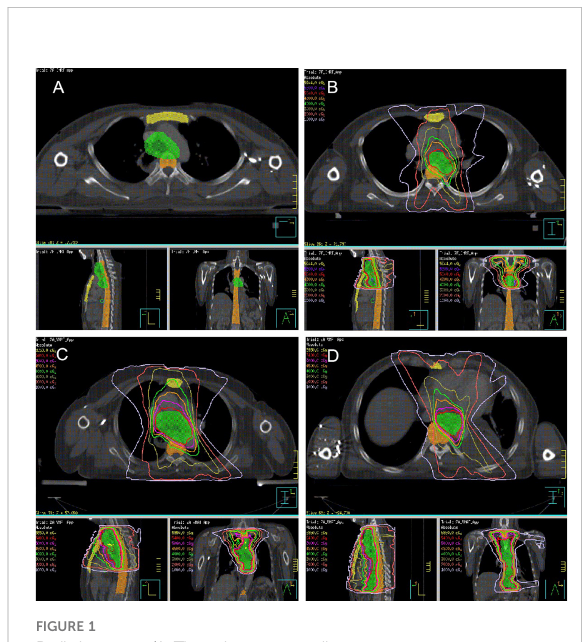
FIGURE 1 Radiation target (A. Thoracic marrow; yellow area, sternum; orange area, thoracic vertebral body; green area, PTV; (B) POCRT; (C) PORT, Upper-thoracic esophagus or Middle-thoracic esophagus with metastasis in 0 to 2 regional lymph nodes or metastasis in ≥ 3 regional lymph nodes in the mediastinum; (D) PORT, Lower-thoracic esophagus or middle-thoracic esophagus with metastasis in ≥ 3 regional lymph nodes distributed in two